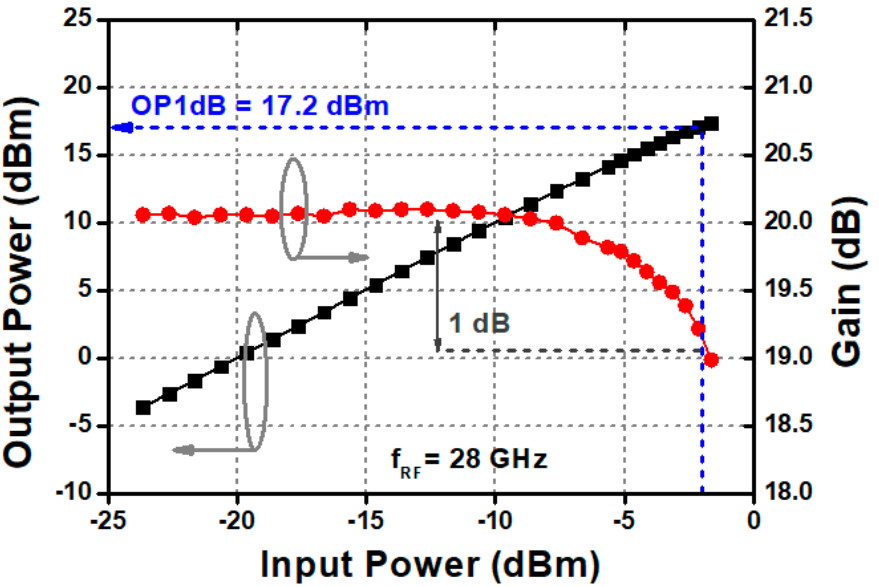
Figure 13. Measured IB OP1dB performance at f RF ( f RF = 28 GHz). Black dot: Fund. Red dot: IM3.